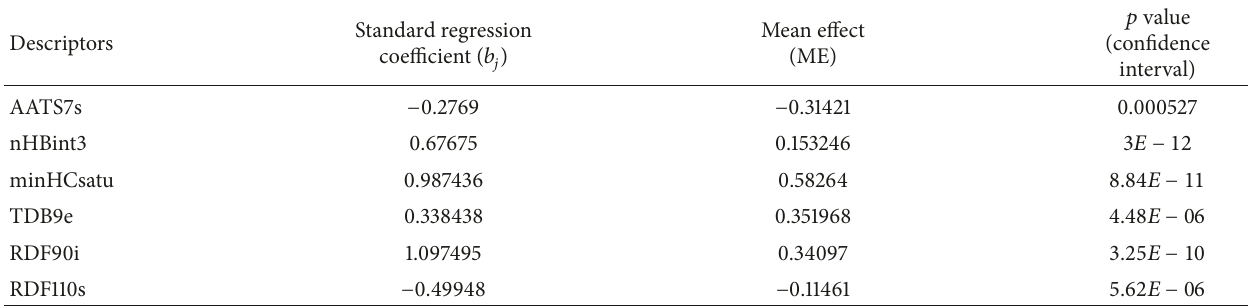
Table 8: Specification of entered descriptors in genetic algorithm-multiple regression